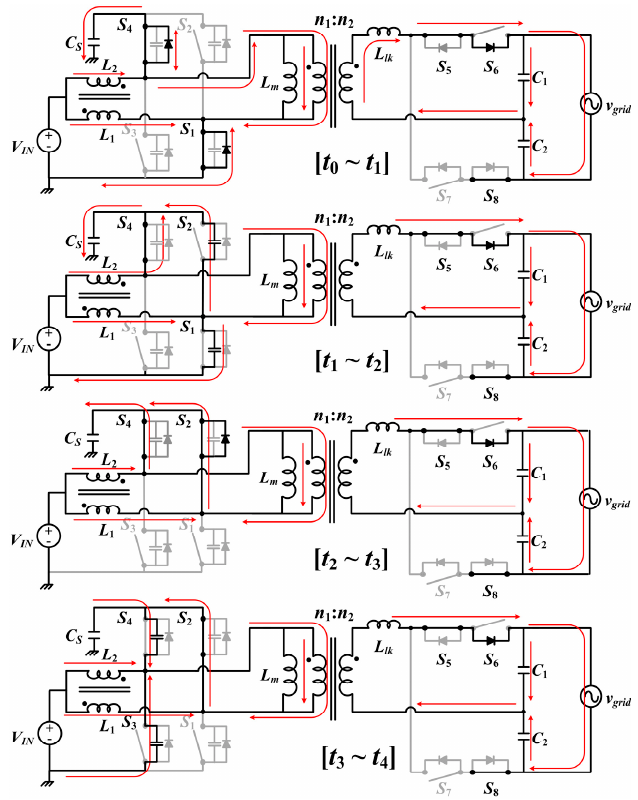
Figure 4. Operating modes when D ≤ 0.5.